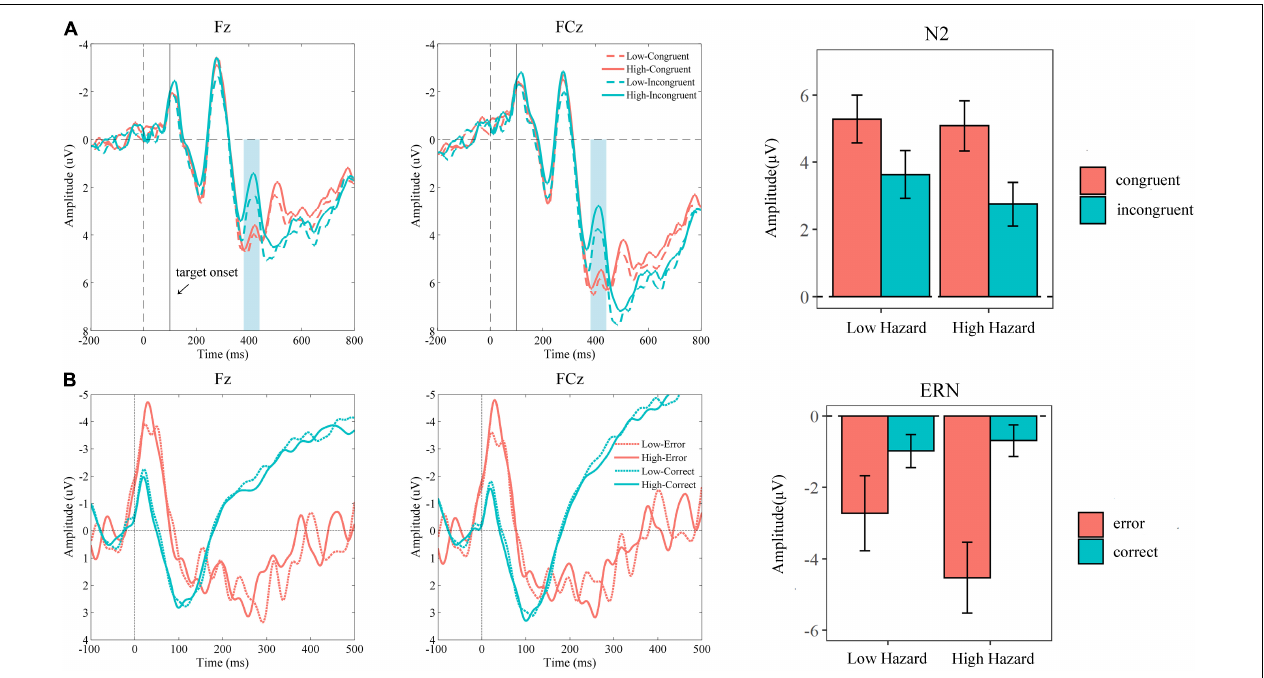
FIGURE 3 | (A) Grand averaged ERP waveforms at Fz and FCz elicited at the stage of conflict processing with the N2 amplitude (from 380 to 430 ms) in conditions of hazard (low vs. high) × congruency (congruent vs. incongruent). (B) Grand averaged ERP waveforms at Fz and FCz elicited at the stage of error processing with the ERN amplitude in conditions of hazard (low vs. high) × response accuracy (error vs. correct). The error bar means the standard error of the